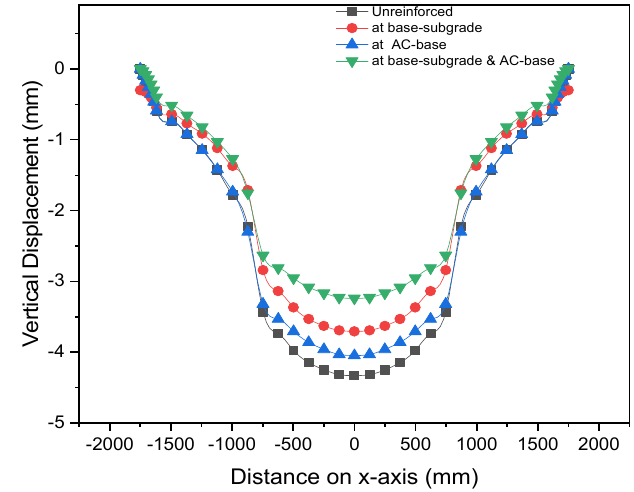
Figure 3. Comparison of vertical displacement on top of the AC.